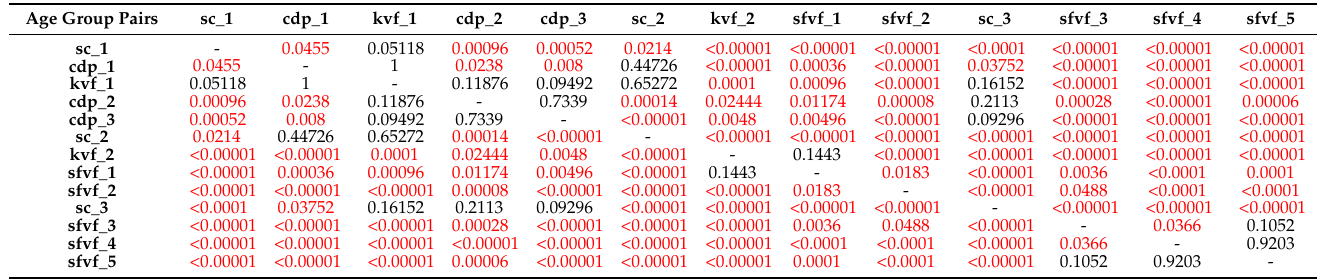
Table 3. Calculated p values of average slope for each group pair. Significant differences are in